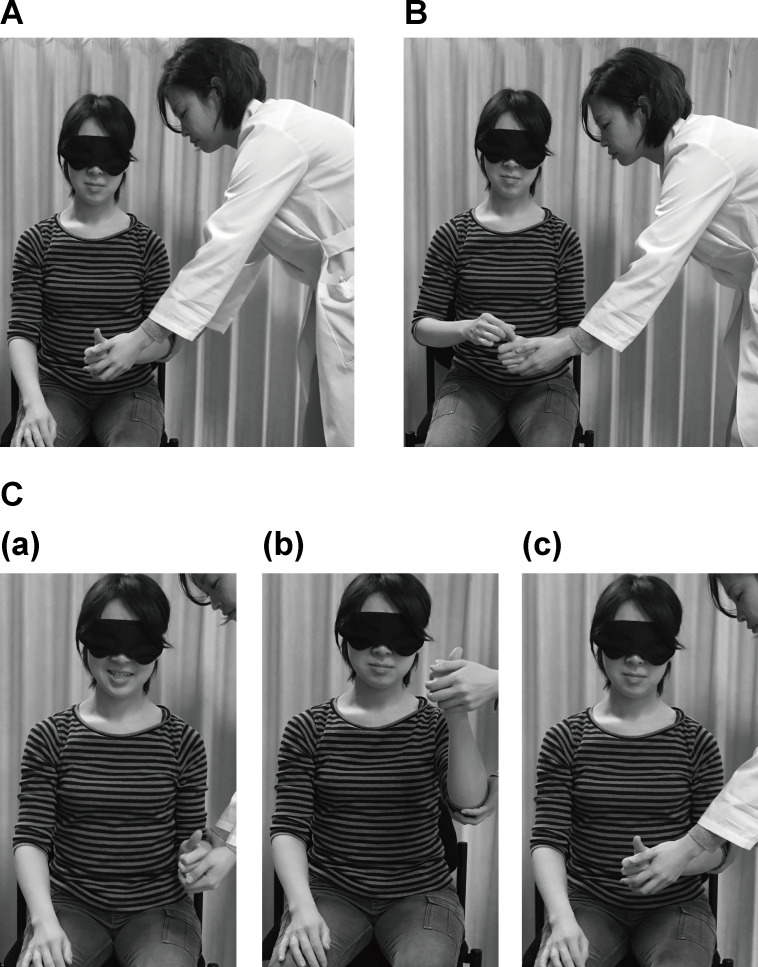
Procedure of the thumb localizing test (TLT).A. The reaching limb is on the ipsilateral knee at the start of the test. B. Participants are instructed to pinch the opposite thumb. C. The limb position of the fixed limb: (a) The forearm in the neutral position, with the elbow at 90° of flexion and the shoulder at 0° of flexion. (b) The forearm in the neutral position, with the elbow at 90° of flexion and the shoulder flexed so that the thumb is at the same level as the mouth. (c) The forearm in the neutral position, with the elbow at 90° of flexion and the shoulder internally rotated so that the thumb is over the midline of the trunk. The individuals pictured in this figure have provided written informed consent (as outlined in PLOS consent form) to publish their image alongside the manuscript.